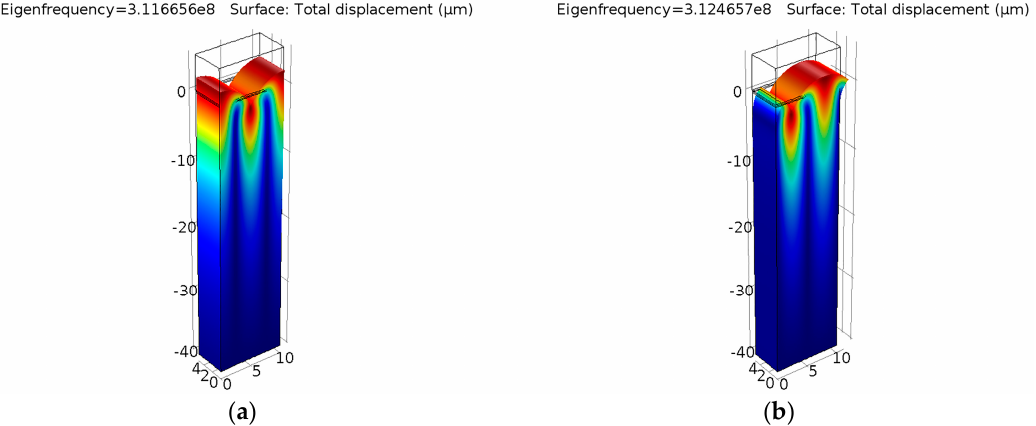
Figure 9. Displacement profiles of periodic layered shorted-grating on ST-X quartz: ( a ) eigenfrequency f ′ sc − = 311.666 (MHz); ( b ) eigenfrequency f ′ sc+ = 312.466 (MHz).